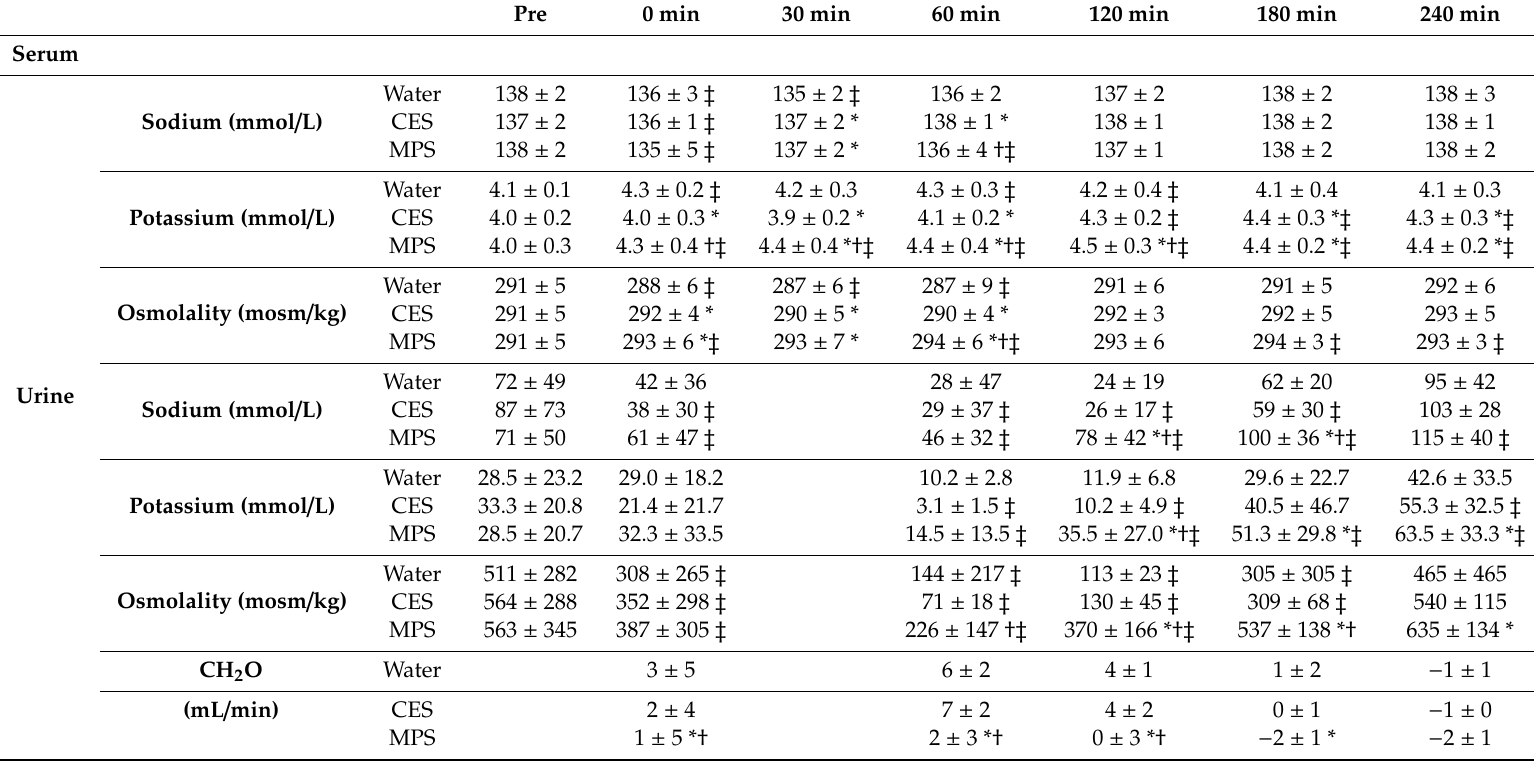
Table 4. Serum and urine electrolyte, osmolality, and urine free water clearance (CH 2 O) values. Values are means ± SD. Di ff erences among beverages were assessed by two-way ANOVA. * p < 0.05 compared to water; † p < 0.05 compared to CES; ‡ p < 0.05 compared to